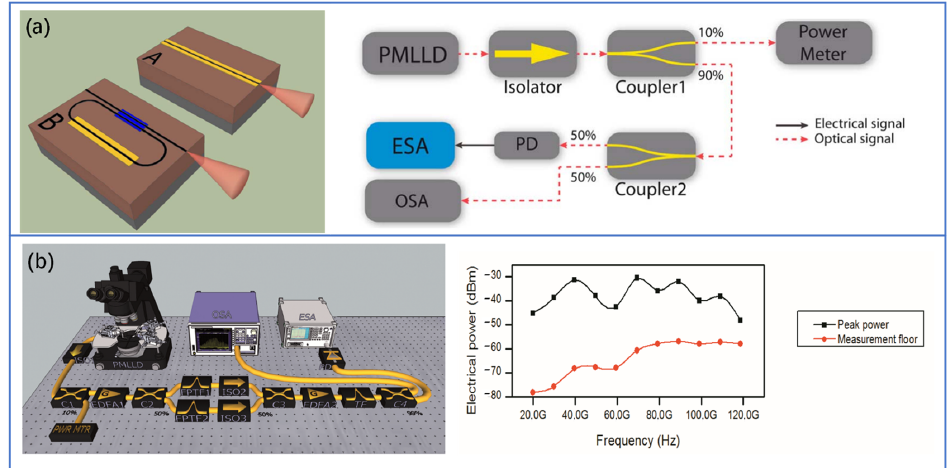
Figure 6. ( a ) Schematic view of laser cavities and experimental setup for electrical signal characterization. © 2012 IEEE. Reprinted, with permission. from [91]. ( b ) One CW sub -THz photonic synthesis setup and electrical peak power (black squares) and measurement floor (red circles) of the electrical signals. Reprinted (adapted) with permission from [93] © The Optical Society, 2012.